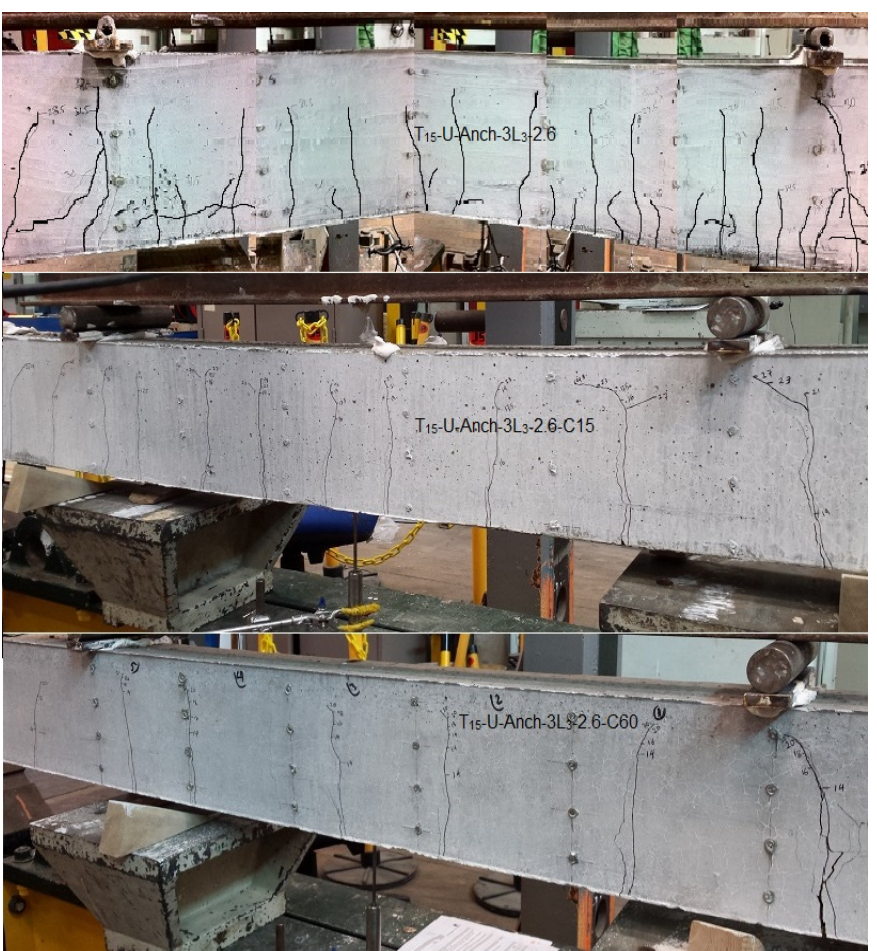
Figure 22. The failure modes and crack patterns of TRC beams with various covers. Concrete's tensile strength is roughly 10% of its compressive strength. The concrete’s low tensile strength usually causes cracking [33]. Crack spacing in reinforced concrete ment ratio, cover thickness, and bond strength [34]. The distance between cracks in TRC concrete is 10 initial cracks, stabilised at an applied load of 20 kN within the constant